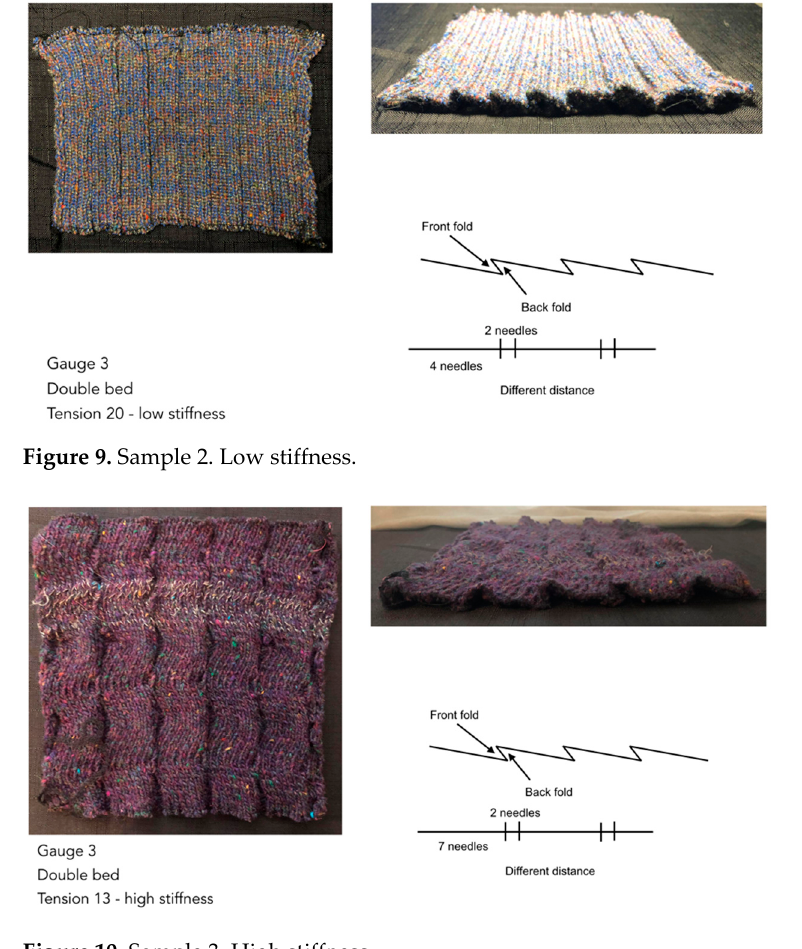
Figure 10. Sample 3. High